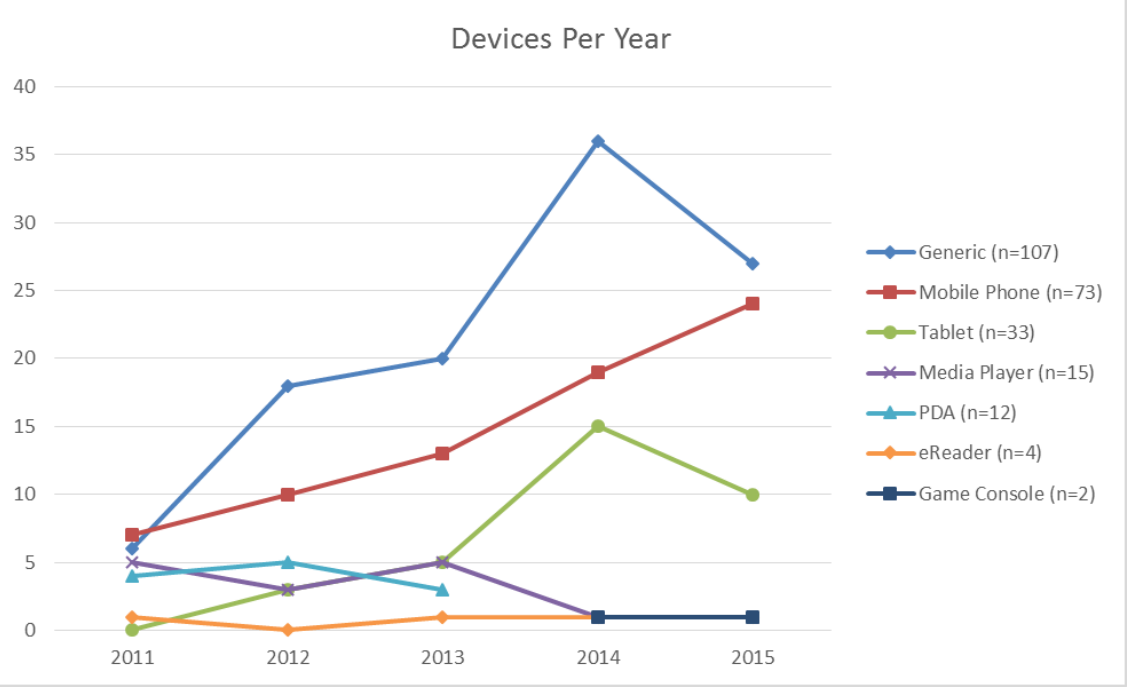
Figure 4. Distribution of devices by